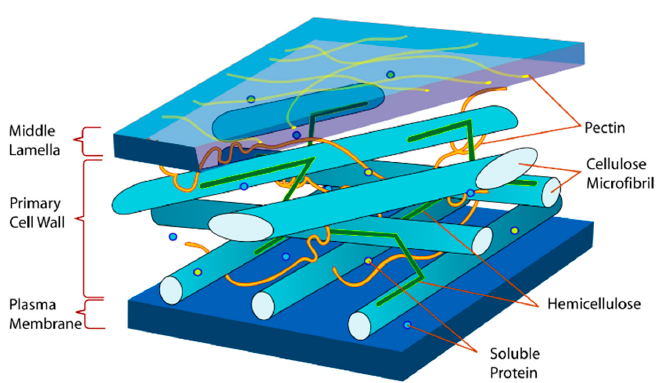
Figure 7. Schematic image of the section of a hemp cell wall; hemicellulose in green [29].